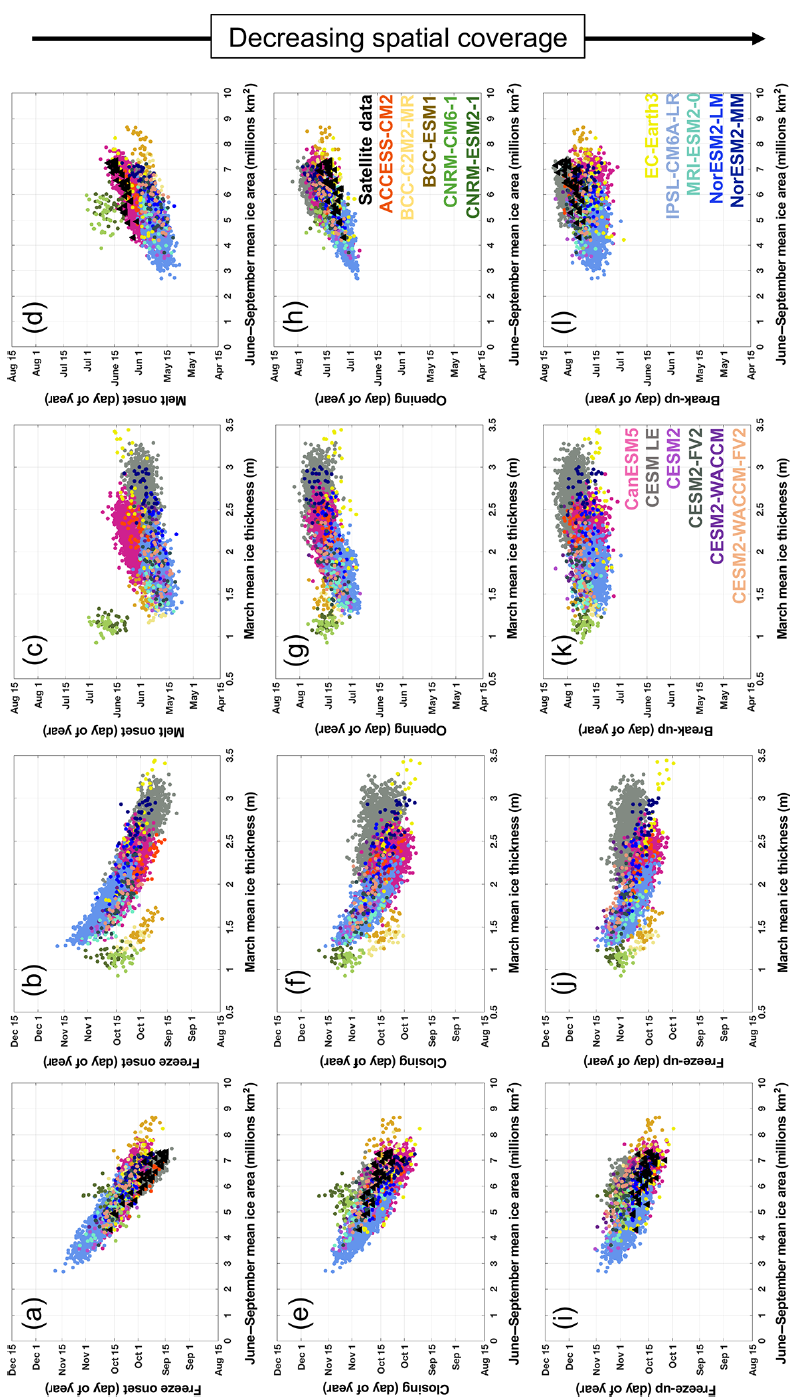
Figure 9. Scatterplots of mean seasonal sea ice transition metrics versus other ice characteristics for CMIP6 models (colors), CESM LE (gray), and satellite data (black). Each scatter point represents 1 year in one ensemble member from 1979 to 2014. Panels (a) – (d) show relationships with mean melt and freeze onset dates, panels (e) – (h) show relationships with mean opening and closing dates, and panels (i) – (l) show relationships with mean breakup and freeze-up dates. Metrics are scattered against mean summer (June–September) ice area in the first and fourth columns and March mean ice thickness in the second and third columns. All metrics are scattered against ice characteristics from the same year, except those in the second column, in which fall transition metrics are scattered against the next year’s mean March ice thickness. All available ensemble members are used for CESM LE, CanESM5, and IPSL. All metrics are calculated between 66 and 84.5 ◦ N. All models are represented in each panel (a) – (l) , but the labels are distributed across panels (h, k, l)